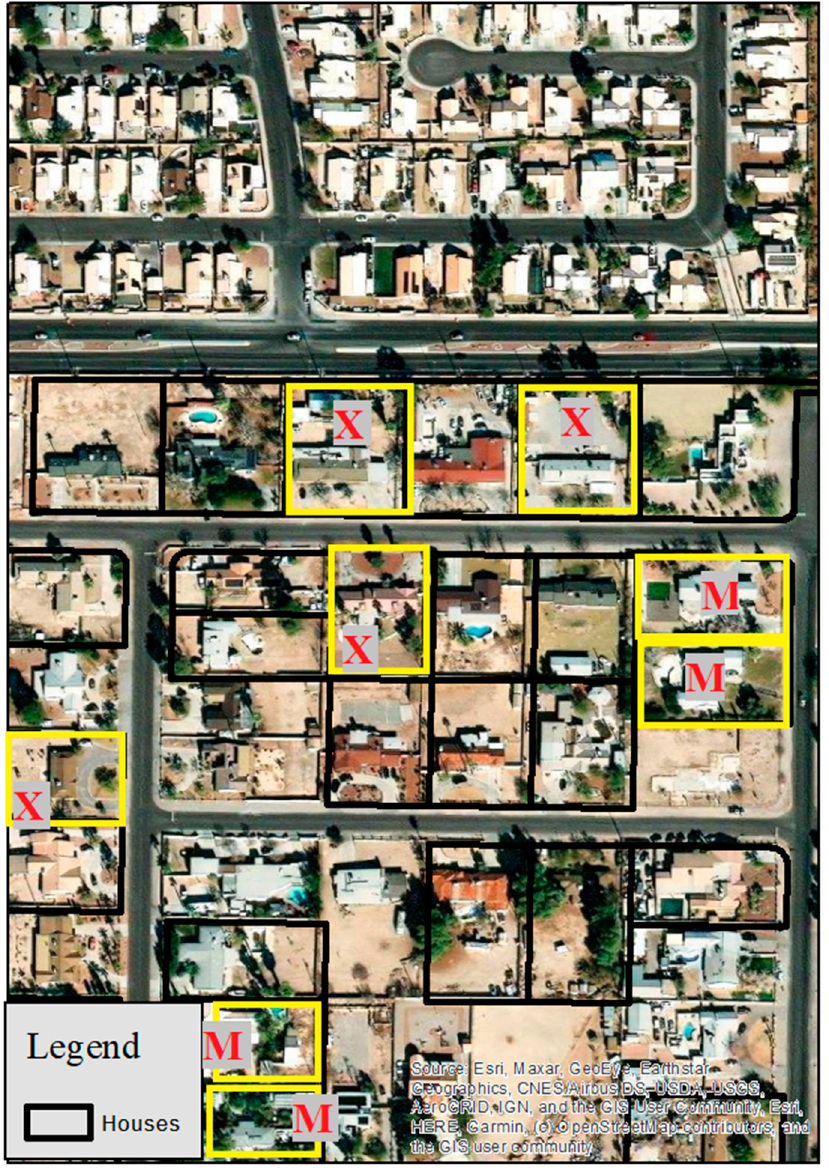
Figure 4. Aerial map of the houses considered in the study area; yellow boxes show the houses considered for the analysis; the letters M and X represent mesic and xeric lawns, respectively.